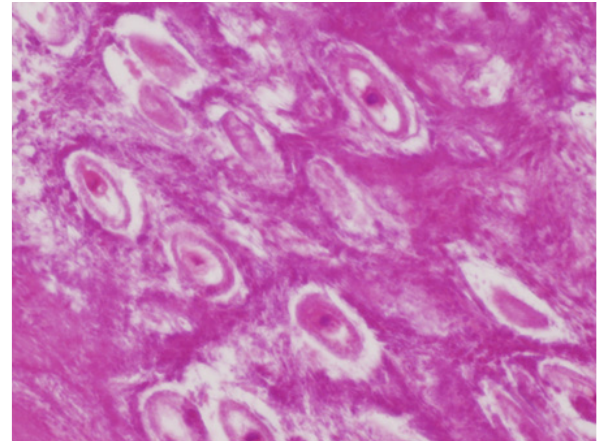
Fig. 2. Target-like chondrocytes in calcified periosteal chon- droma. HE, x200.